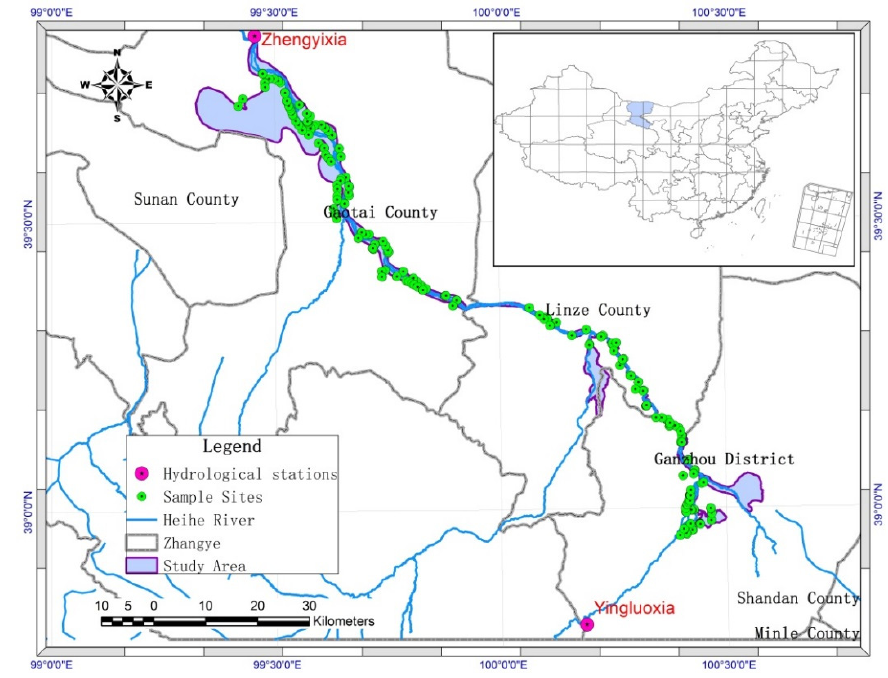
Figure 1. Study area and the verification points in the Heihe River Basin in northwest China.